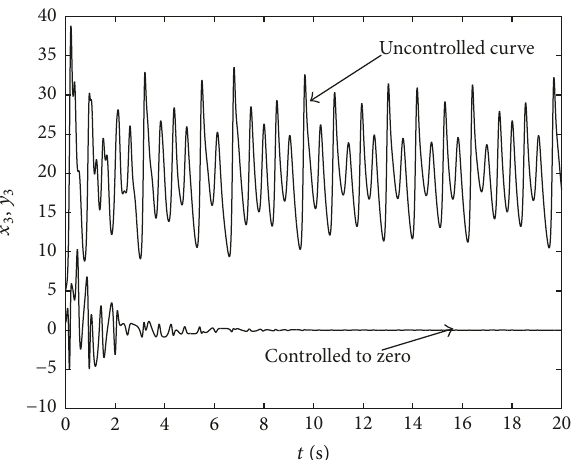
Figure4:Thethirdstatevector (𝑦 3 ) oftheChensystemiscontrolled to the zero.